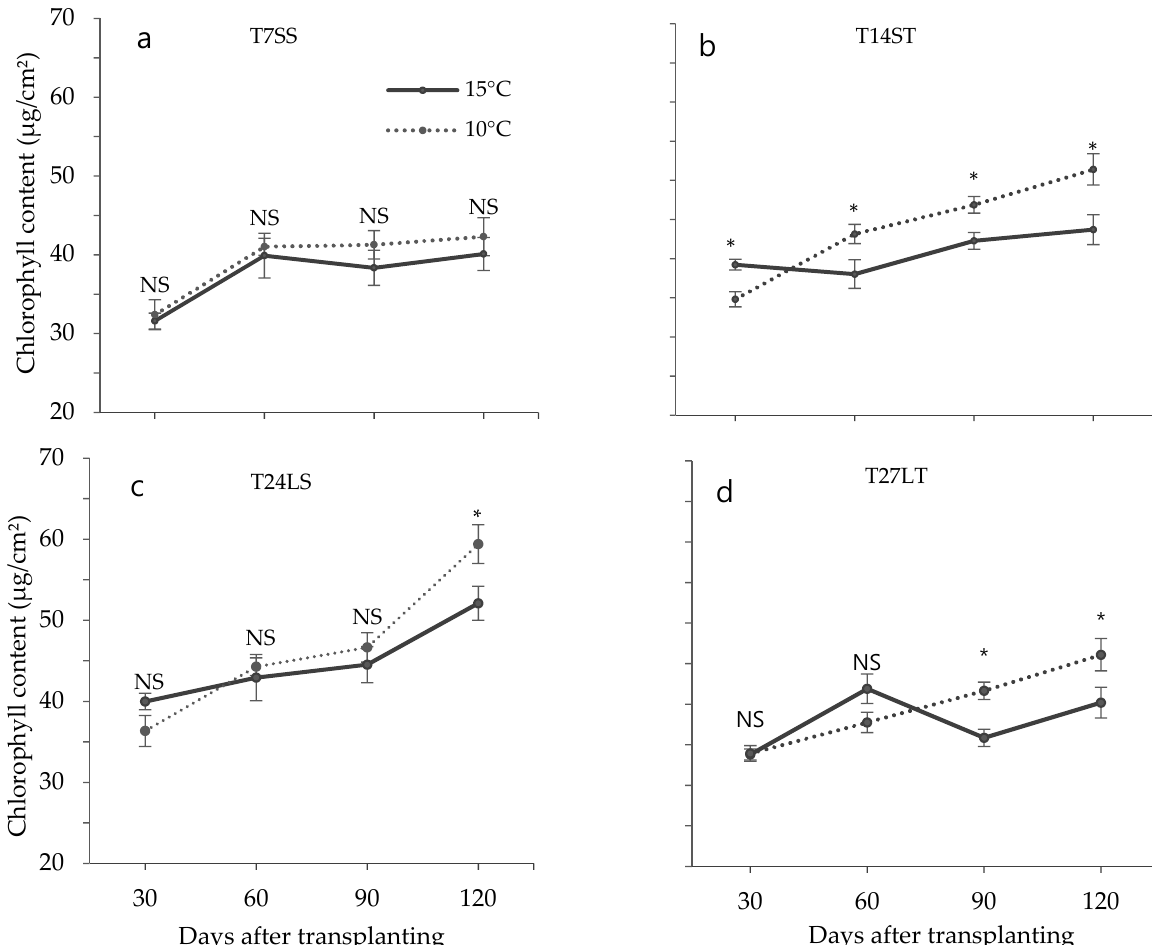
Figure 7. Changes in chlorophyll contents in the leaves of cherry-type accessions T7SS ( a ) and T14ST ( b ), and of large-fruit-type accessions T24LS ( c ) and T27LT ( d ) grown in 10 and 15 °C. SS: small sensitive, ST: small tolerant, LS: large sensitive and LT: large tolerant. Values are means ± SD (n = 3). NS and * indicate not significant and significant at the p ≤ 0.05 level in t -test, respectively.